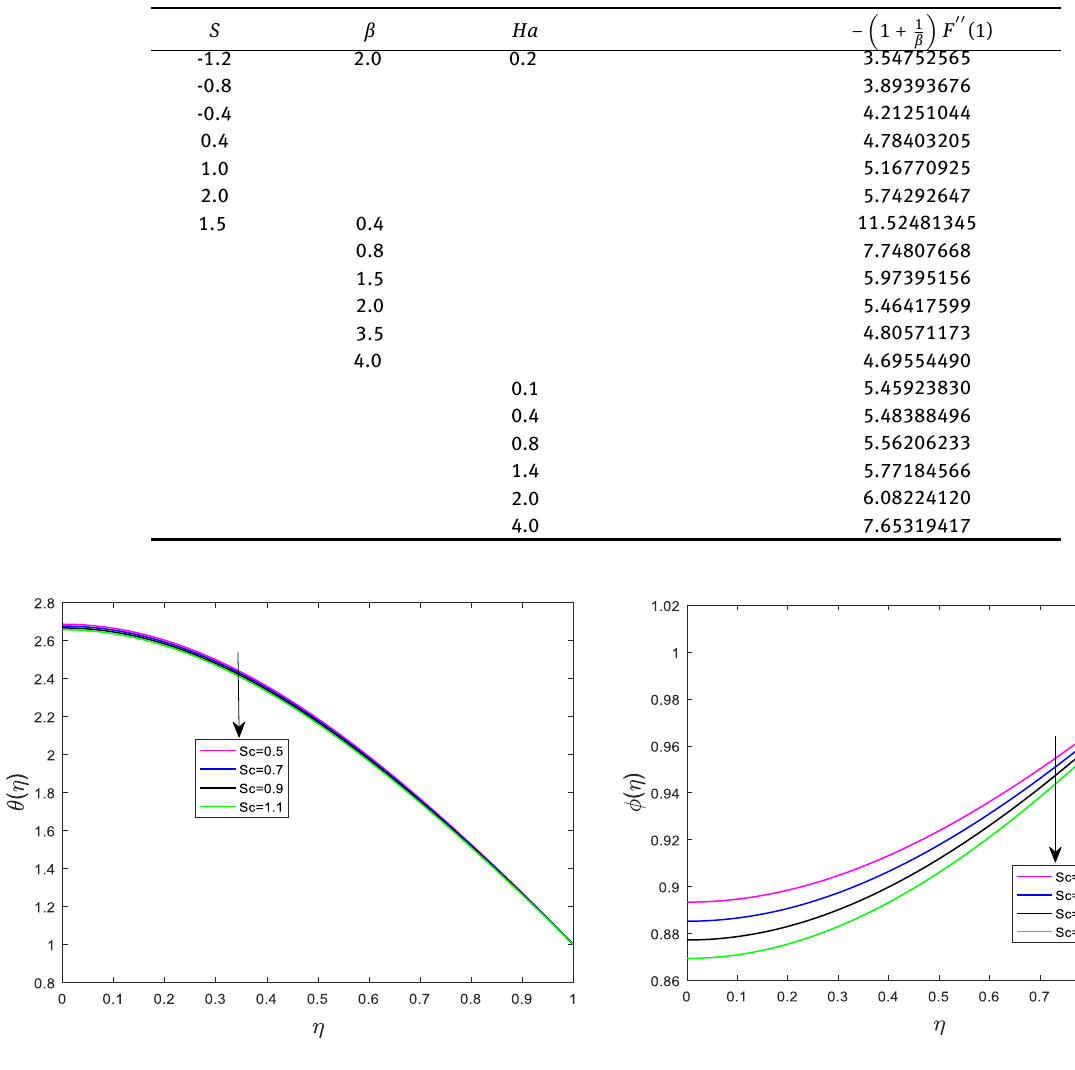
Figure 27: Effect of Sc on ϕ ( η ) for fixed S = N t = Ec = Kr = 0.1, Ha = N = β = Ω = Ω = 0.5 and Pr = T C b